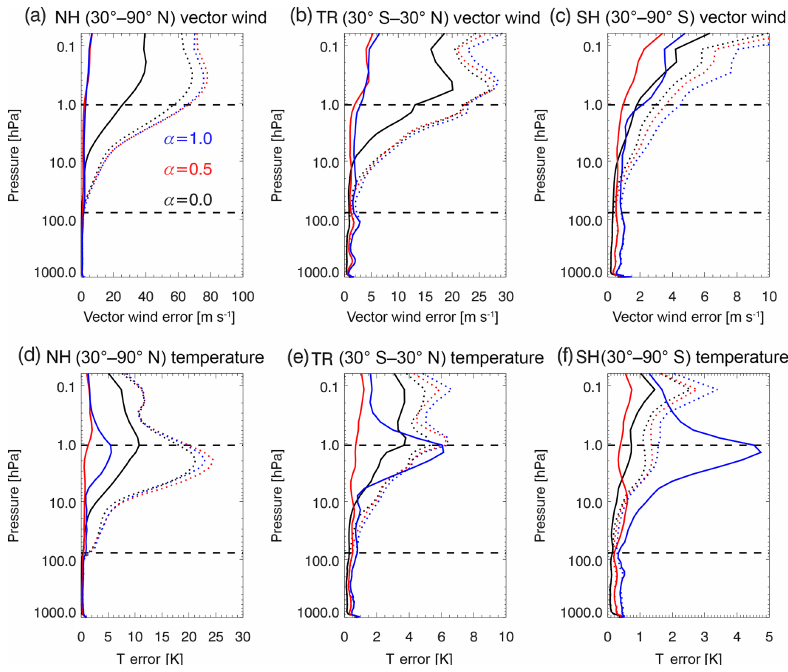
Figure 15. The rms vector wind errors (ms − 1 ) for (a) NH, (b) TR, and (c) SH and rms temperature errors (K) for the (d) NH, (e) TR, and (f) SH averaged from 25 November to 1 December 2014. Solid (dotted) lines are for ozone assimilation experiments (baselines) with α = 0 . 0 (black), 0.5 (red), and 1.0 (blue). Horizontal dashed lines indicate vertical range of assimilated stratospheric ozone observations. Note that the ranges of the horizontal axes for each panel vary based on maximum baseline errors. See Table 1, Sect.